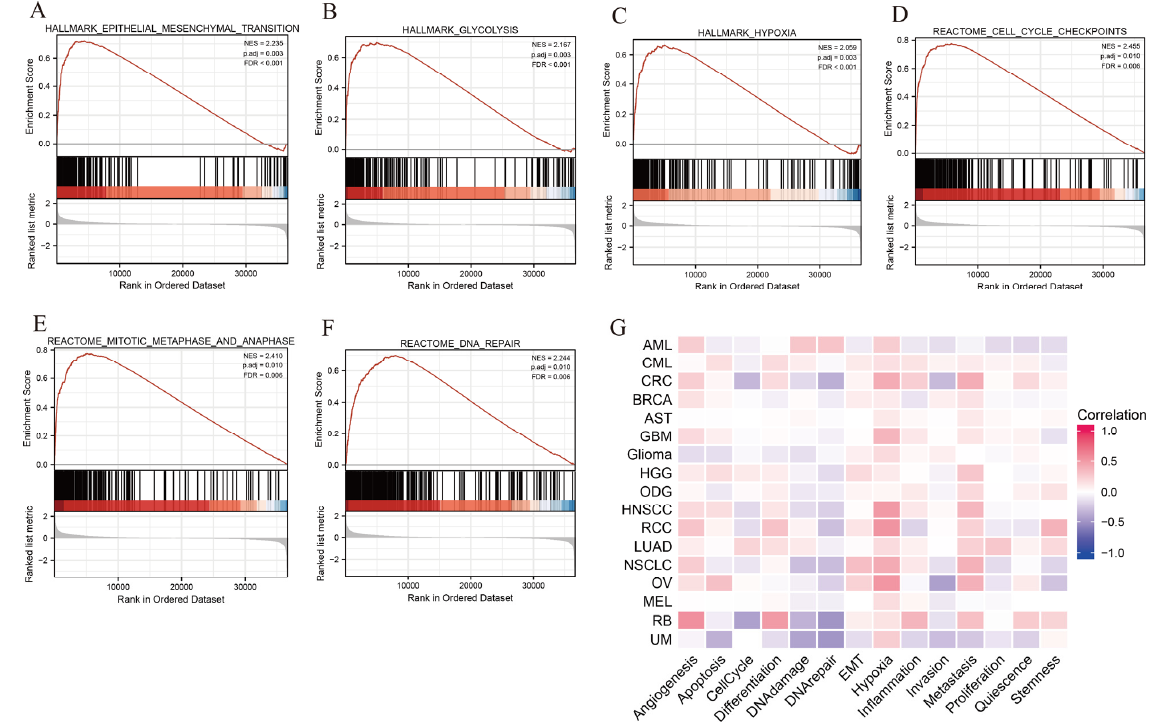
Figure 12. GSEA of SLC2A1-related DEGs based on HALLMARK gene sets ( A – C ) and based on REACTOME gene sets ( D – F ); single-cell analysis based on the CancerSEA database ( G ).